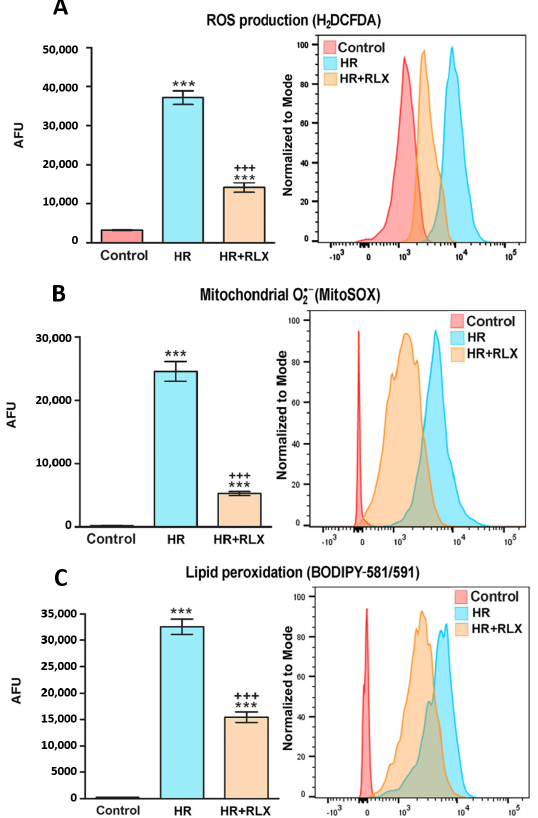
Figure 1. Quantitative evaluation and representative FACS diagrams of cellular oxidative stress assayed by fluorescent probes. ( A ) Endogenous ROS, determined by H 2 DCFDA; ( B ) mitochondrial